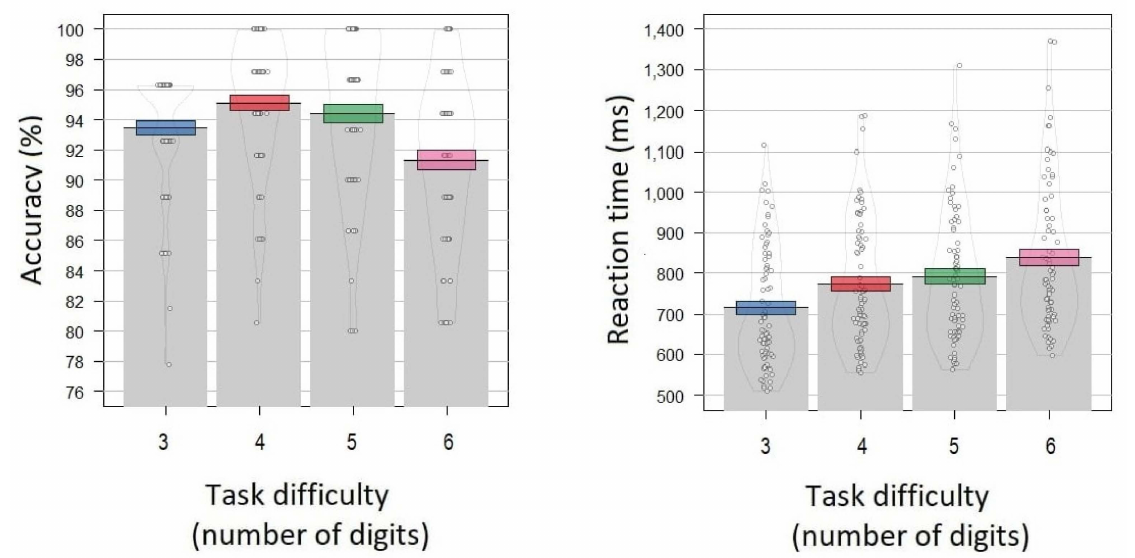
Figure 3. Behavioral results of the Sternberg task. ( Left panel ): y -axis—accuracy (percentage of correct responses averaged across participants). ( Right panel ): y -axis—reaction time averaged across participants. x -axis—the task difficulty condition (3, 4, 5, 6 digits in the encoding set). Grey bars and black lines indicate means. Colored bands indicate ± 1 standard errors (blue color corresponds to the 3 digits condition, red—4 digits, green—5 digits, pink—6 digits). Dots and density curves indicate data